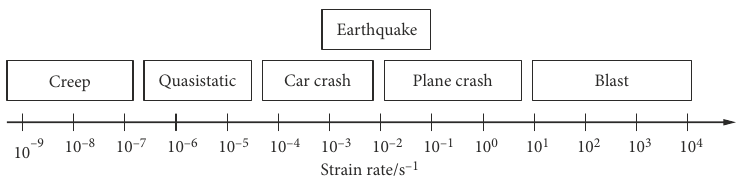
Figure 2. Loading strain rates and the corresponding static and dynamic action